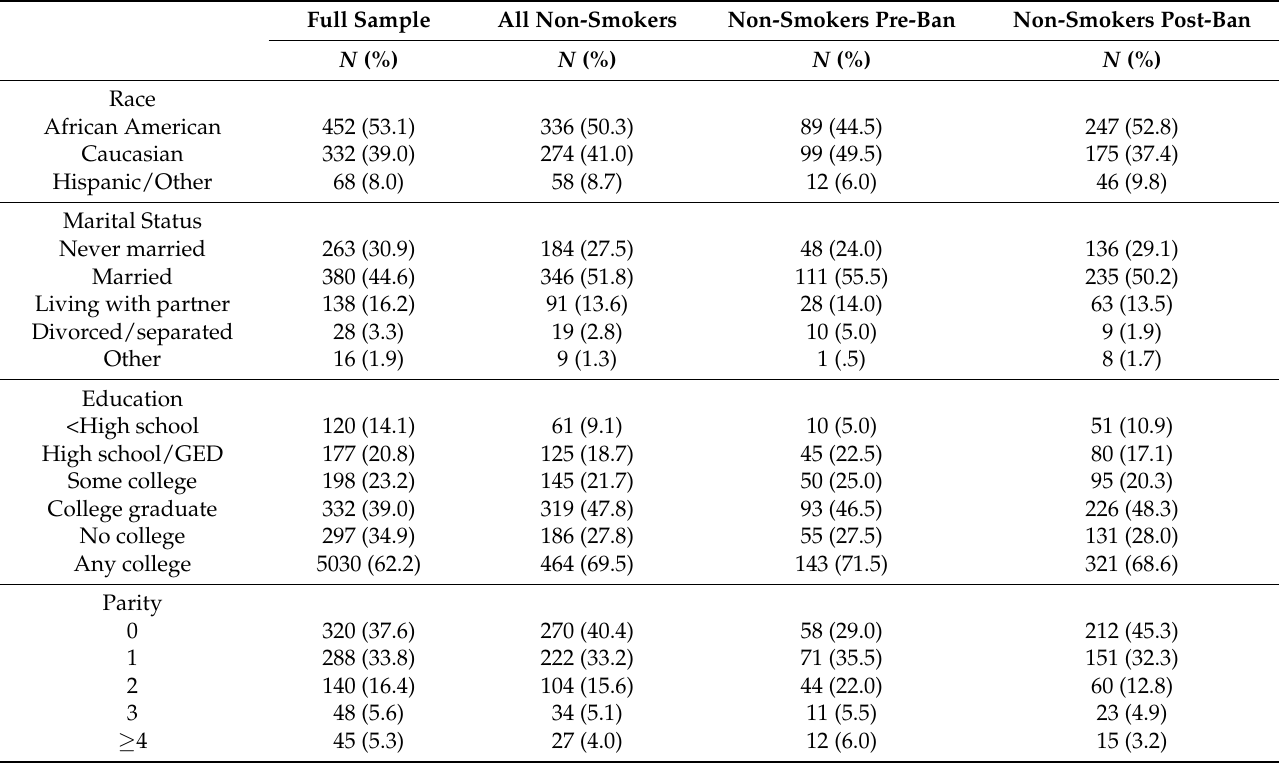
Table 1. Sociodemographic characteristics for full sample, non-smokers, and non-smokers before and after the 2010 smoking